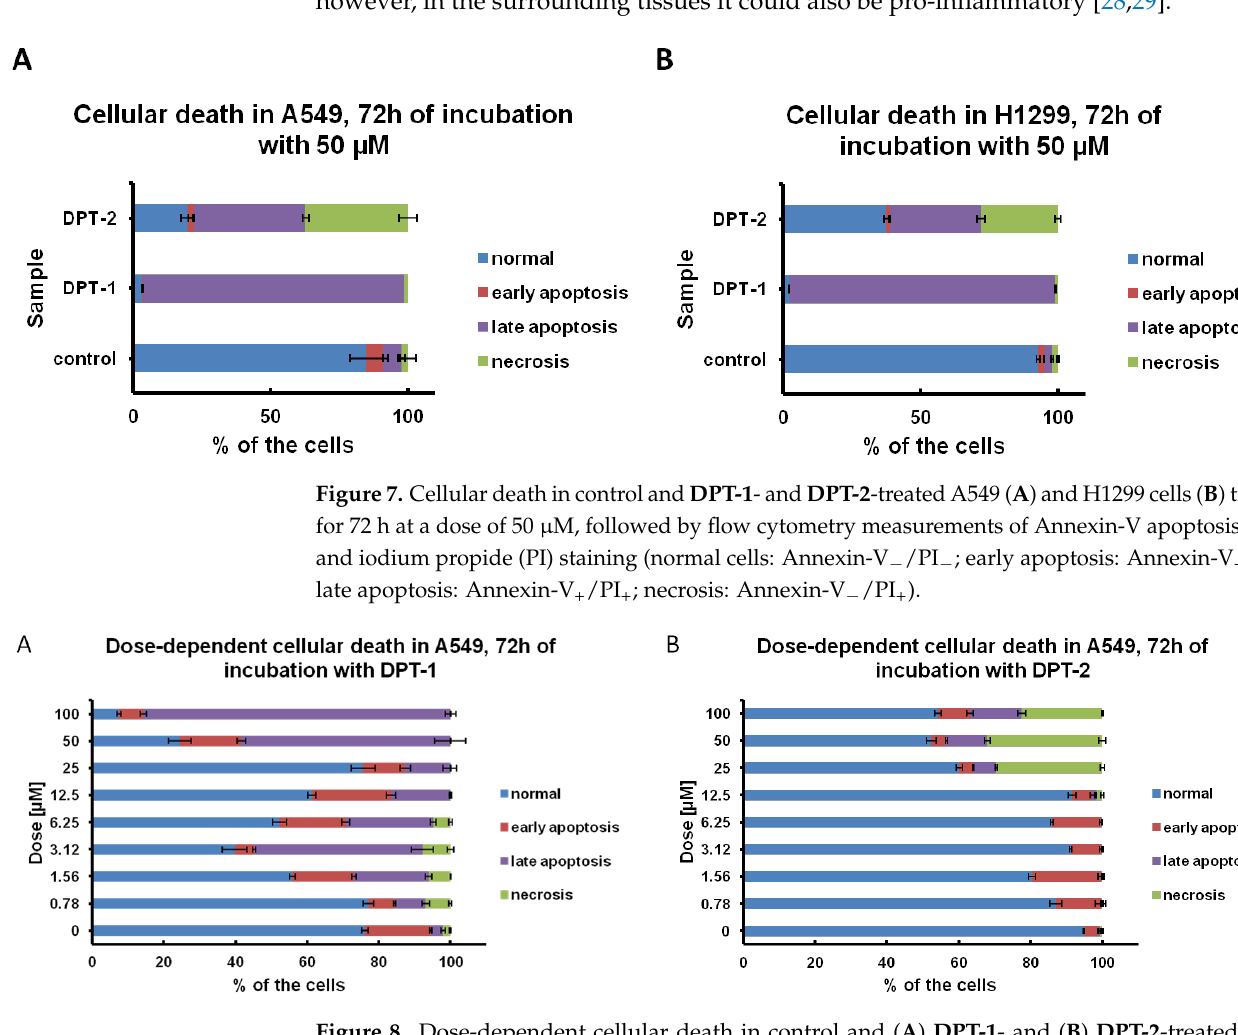
Figure 8. Dose-dependent cellular death in control and ( A ) DPT-1 - and ( B ) DPT-2 -treated A549 cells treated for 72 h, followed by flow cytometry measurements of Annexin-V apoptosis assay and iodium propide (PI) staining (normal cells: Annexin-V − /PI − ; early apoptosis: Annexin-V+/PI − ; late apoptosis: Annexin-V + /PI + ; necrosis: Annexin-V − /PI + ).